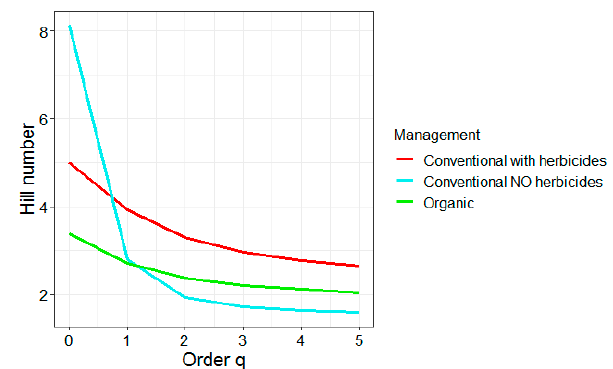
Figure 4. Diversity (Hill numbers) profile for the different management orchards. The x- axis is the order q , 0 ≤ q ≤ 5. The y- axis is the Hill number (the effective number of equally abundant species).